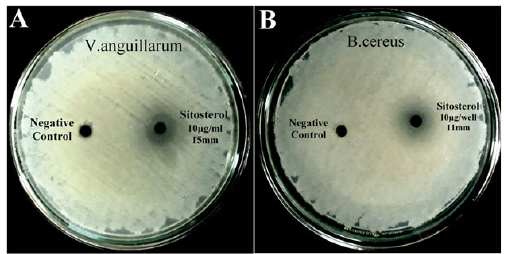
Fig. 4. Antibacterial activity of β-sitosterol; A: against Vibrio anguillarum ; B: against Bacillus cereus Table 3. Phytochemical secondary metabolites present in crude extracts of Parthenium hysterophorus based on gas chromatography mass spectrum (GC-MS) analysis Phytochemical